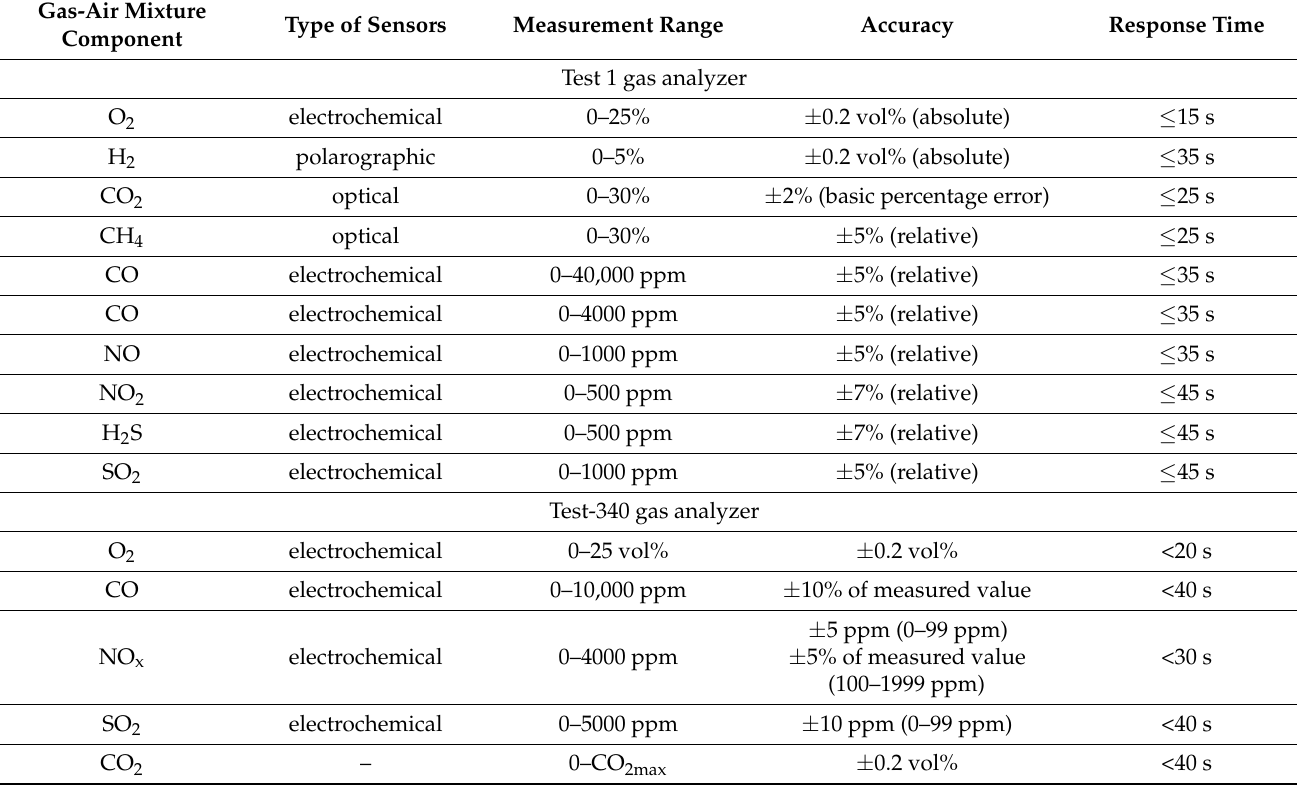
Table 3. Characteristics of gas analyzers in the